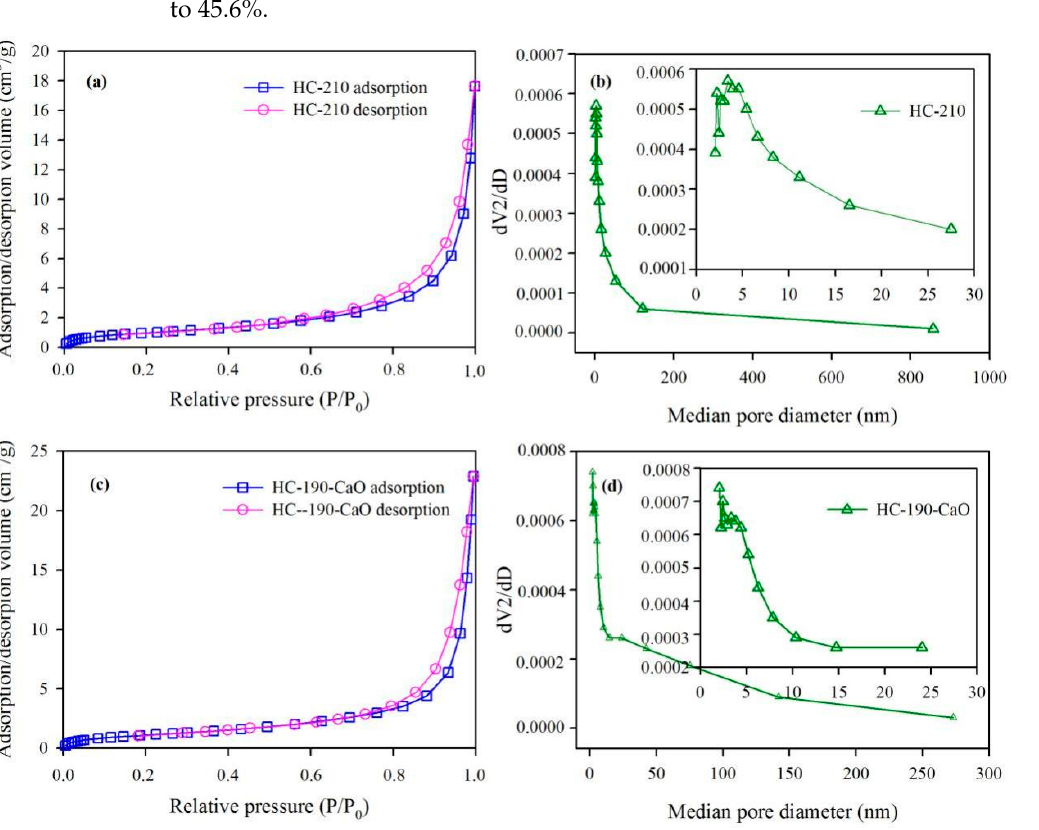
Figure 5. N 2 adsorption–desorption isotherms and pore size distribution of HC products. HC-210: ( a ) and ( b ); HC-190-CaO: ( c ) and ( d ).